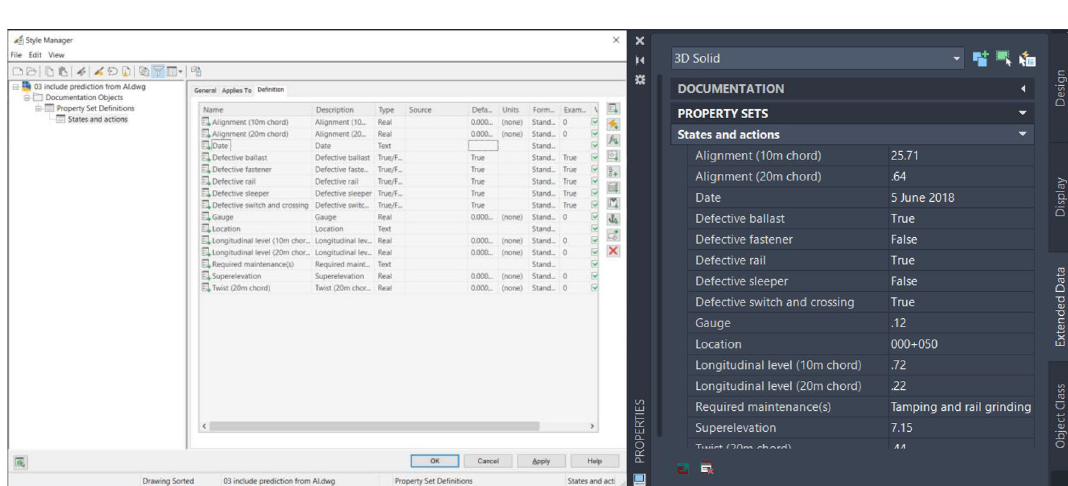
Figure 13. Results from sensitivity analysis and hyperparameter tuning ( a ) learning rate, ( b ) log(epsilon), and ( c ) discount factor.